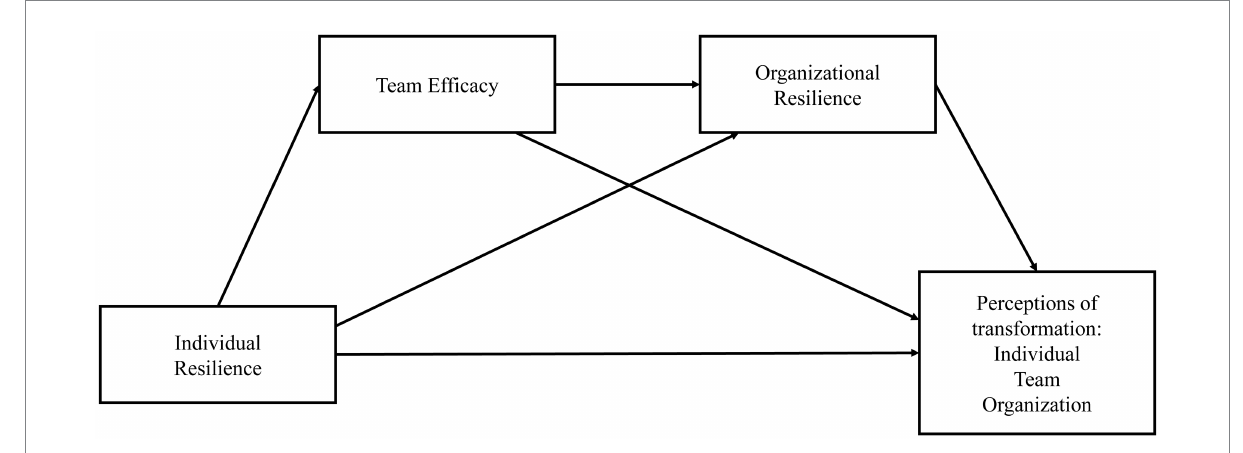
FIGURE 1 Proposed research model: sequential